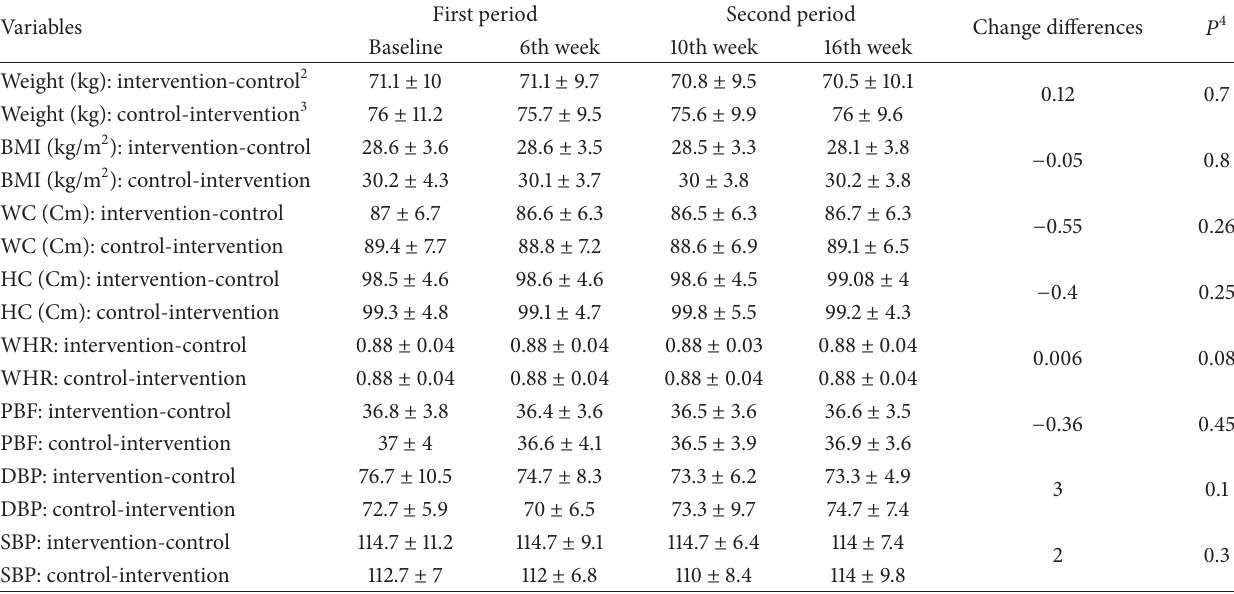
Table 2: The effects of soy bean flour enriched bread intake on anthropometric indices and blood pressure in type 2 diabetic women 1 . First period Second period Variables